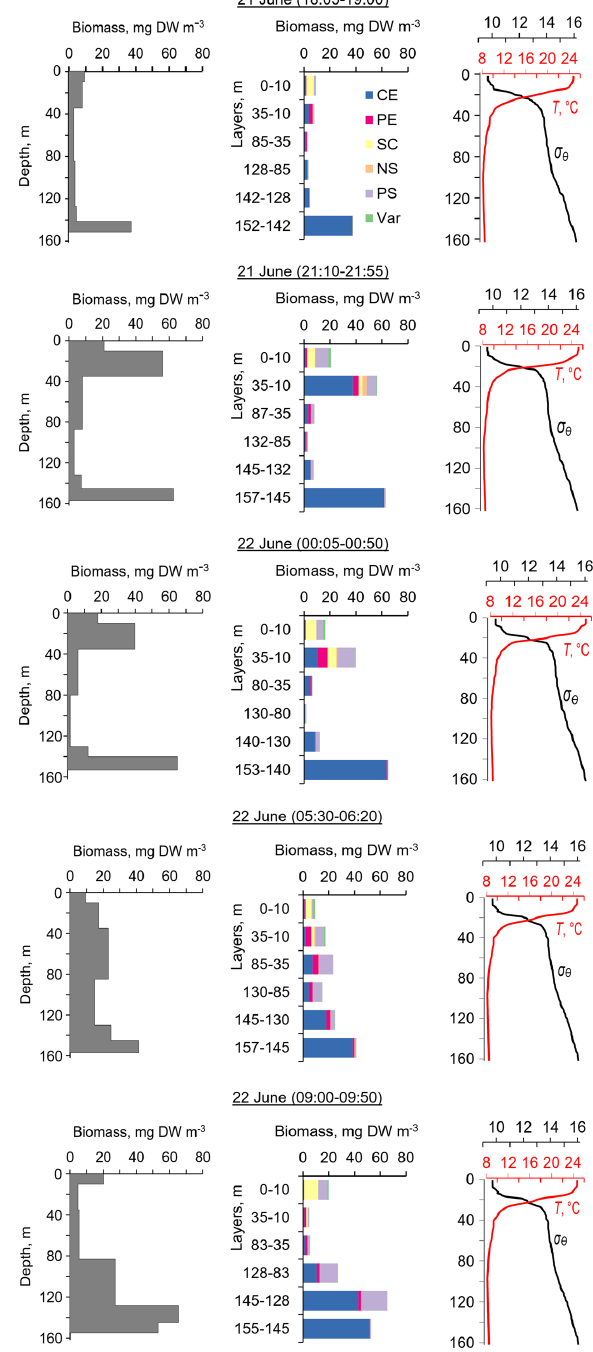
Figure 4. The diel changes in vertical distributions of (left) total mesozooplankton biomass, (middle) zooplankton composition, and (right) temperature ( T ) and density ( σ (cid:50) ) near the mooring site on 21 and 22 June 2010. The temperature and density profiles were used for the selection of sampling strata. CE – Calanus euxinus ; PE – Pseudocalanus elongatus ; SC – small crustaceans; NS – Noctiluca scintillans ; PE – Parasagitta setosa ; Var –